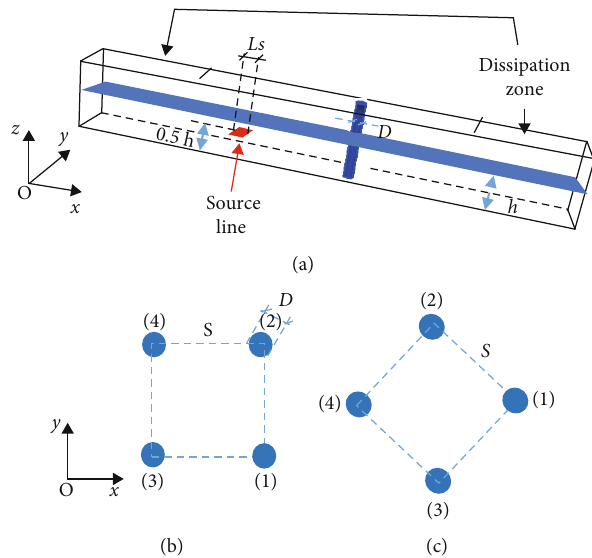
Figure 1: The computational domain and wave source line location; (a) side view; (b) top